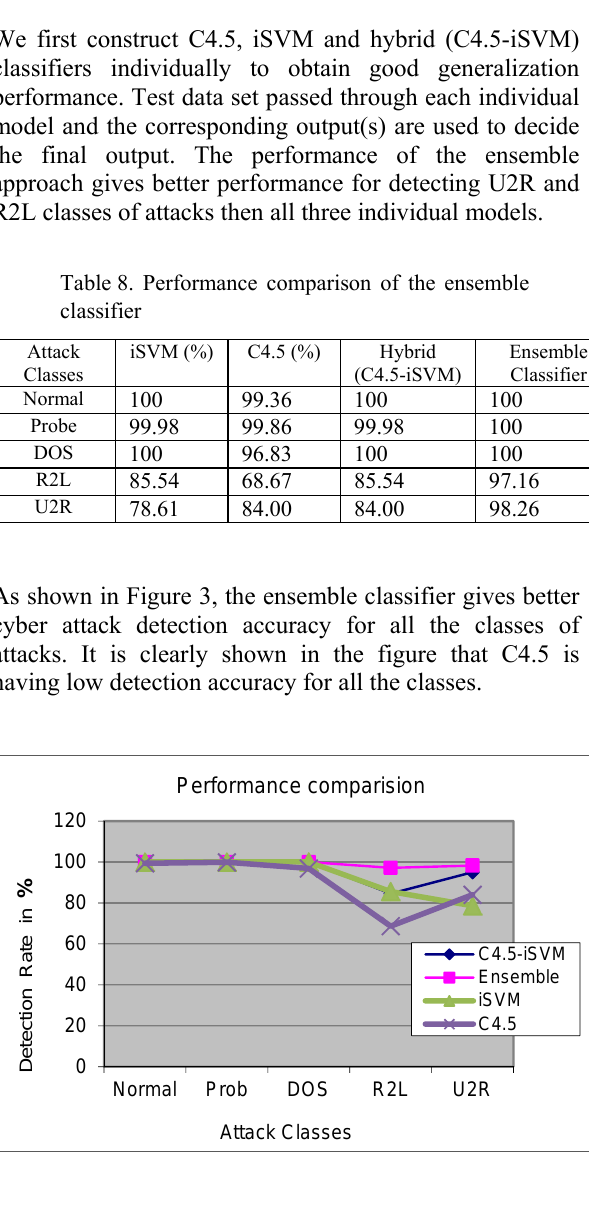
Fig. 3 Performace Comparision of Ensemble Classifier with other